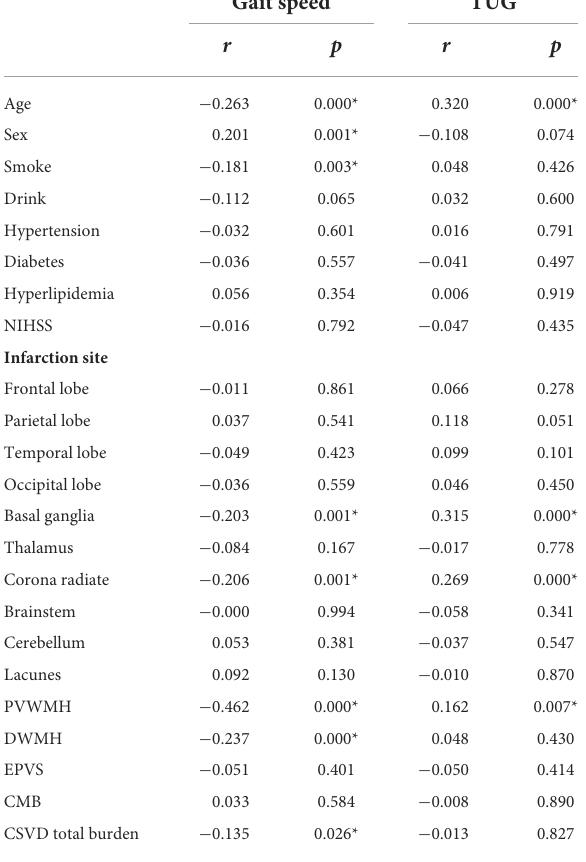
TABLE 3 Linear analysis of CSVD markers and total burden associated with gait and balance. Gait speed